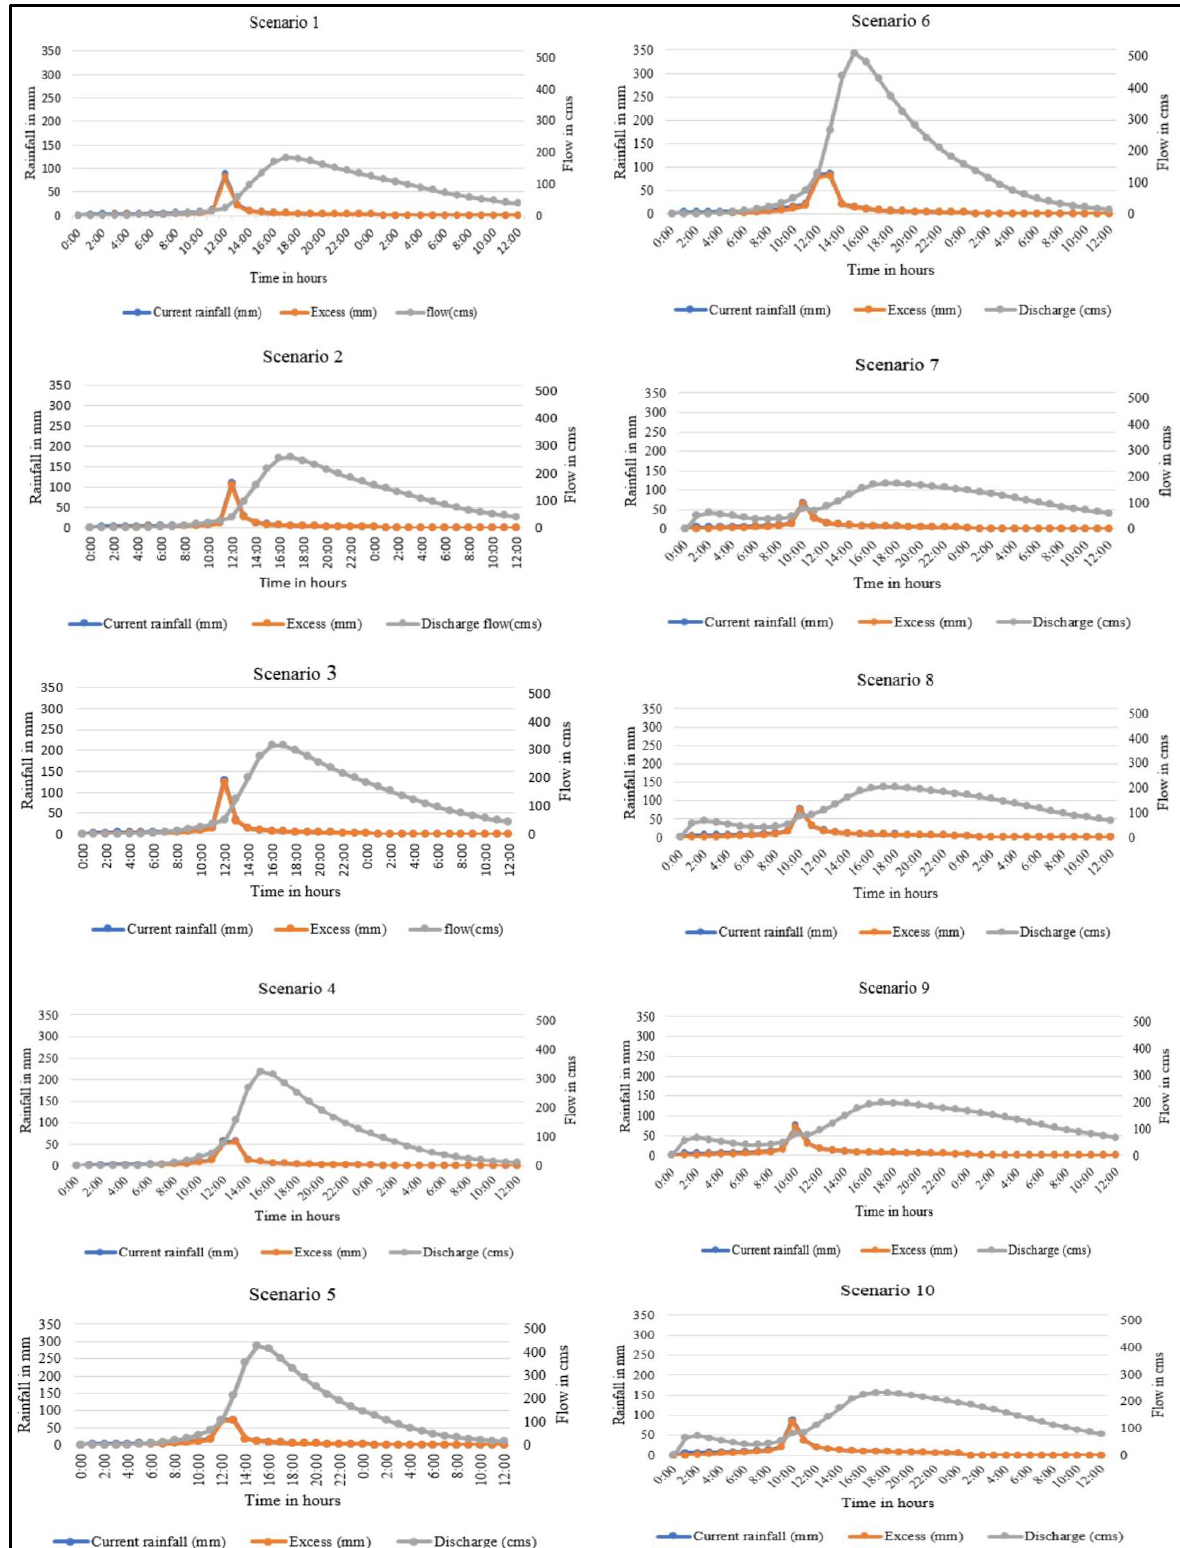
Figure 3. Hydrographs for ten different land use and climate change scenarios. A Pearson product-moment correlation coefficient was computed to assess the rela- tionship between the peak rainfall values of 50- and 100-year return periods for the years 2016 and 2030 with consideration of the infiltration facilities and runoff volume at the